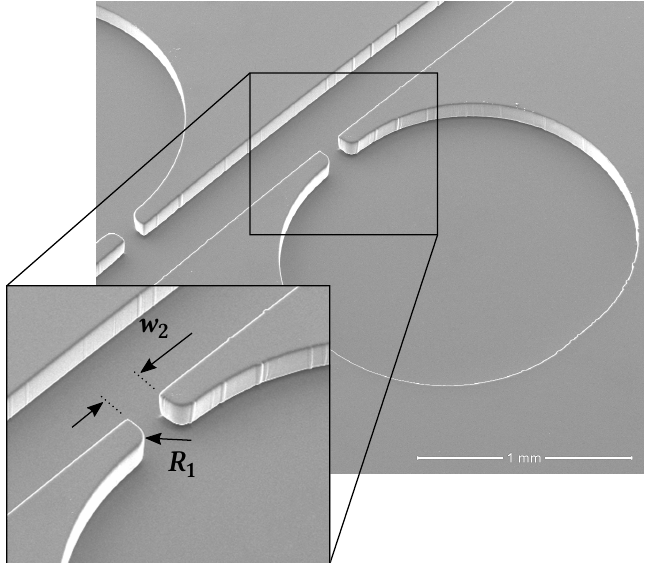
Figure 6. SEM image of the optimal pressure tap configuration: w 2 = 108 µ m and R 1 = 50 µ